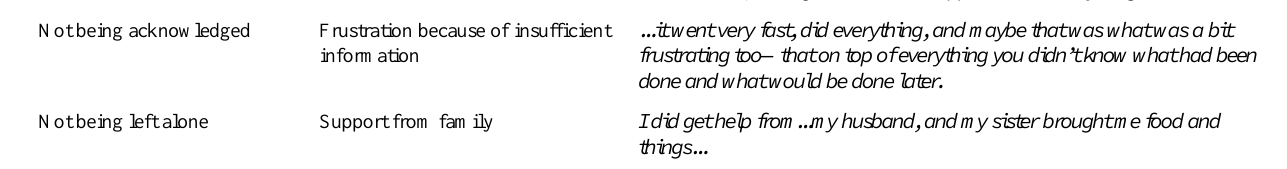
Data extractCodesTheme and subtheme ...It’s like when you have experience of having had an operation and coming home; you kind of know what you can manage.